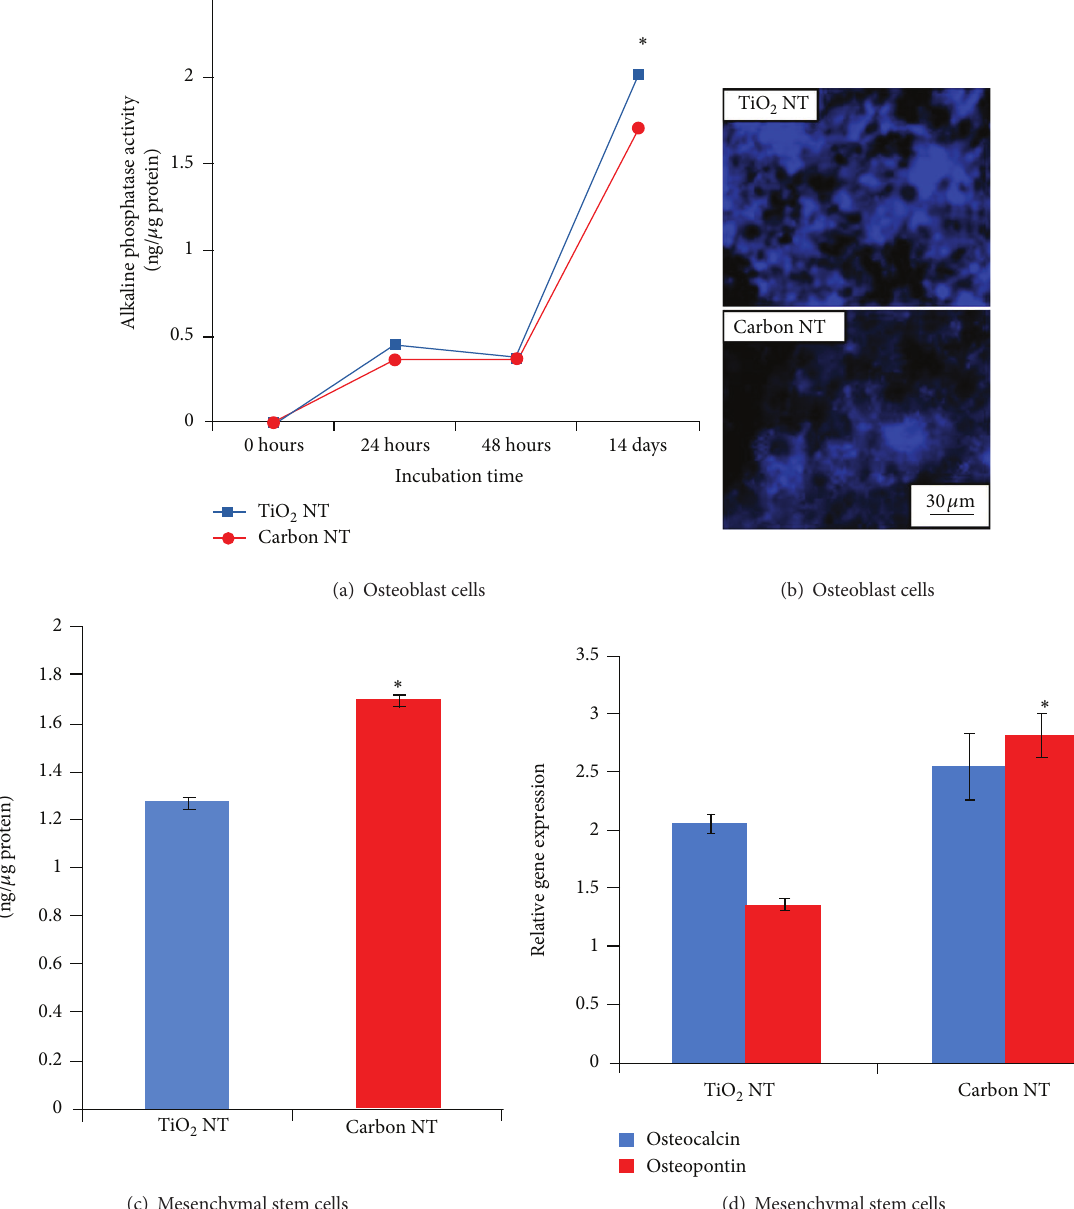
Figure 8: Comparison of the degree of osteoblast functionality and MSC differentiation and maturation in late stage culture (3 weeks) on the TiO 2 versus carbon chemistry nanotube surfaces. ALP activity for osteoblasts (a) and MSCs (c) cultured on the nanotube surfaces shows different favorable chemistries. (b) Fluorescent images showing ALP staining of osteoblast cells verifying data shown in (a). (d) Quantitative PCR analysis of the MSCs on each surface for osteocalcin and osteopontin, verifying the trend in